Question: What type of chart is this?
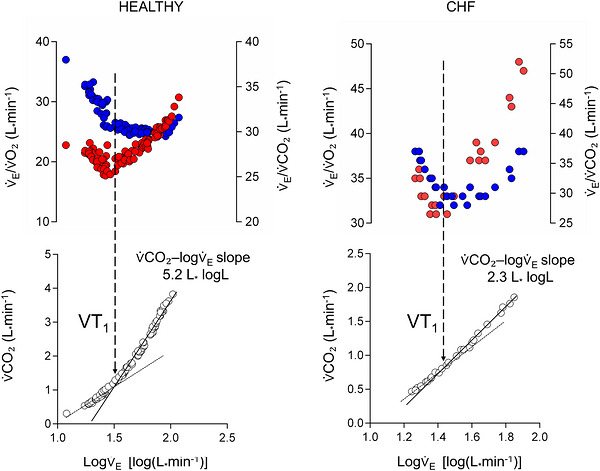
Answer: line